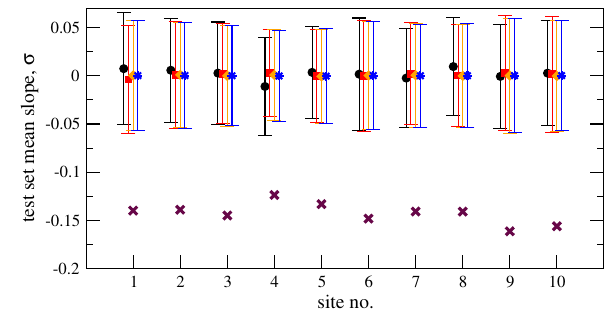
Figure 1. Example DSI records of significant negative trends in Argentina along latitude 30.025 ◦ S: 64.225 ◦ W (black), 64.025 ◦ W (red), and 63.775 ◦ W (blue). Solid lines indicate fitted linear trends. 8 days, apart from the necessary cuts at the end of each year.